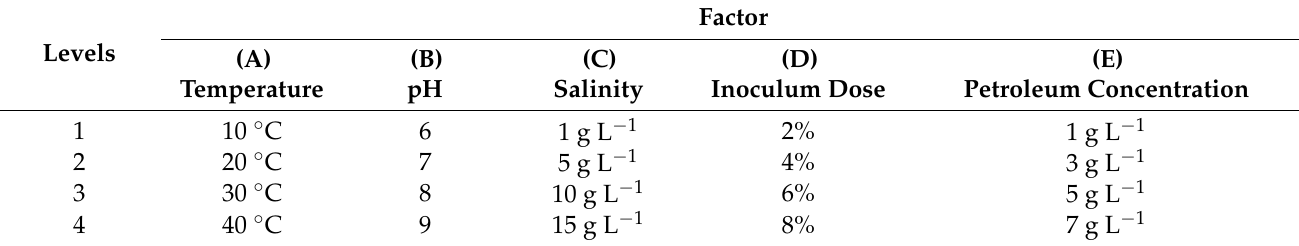
Table 1. Design of environmental factors and level of orthogonal test.